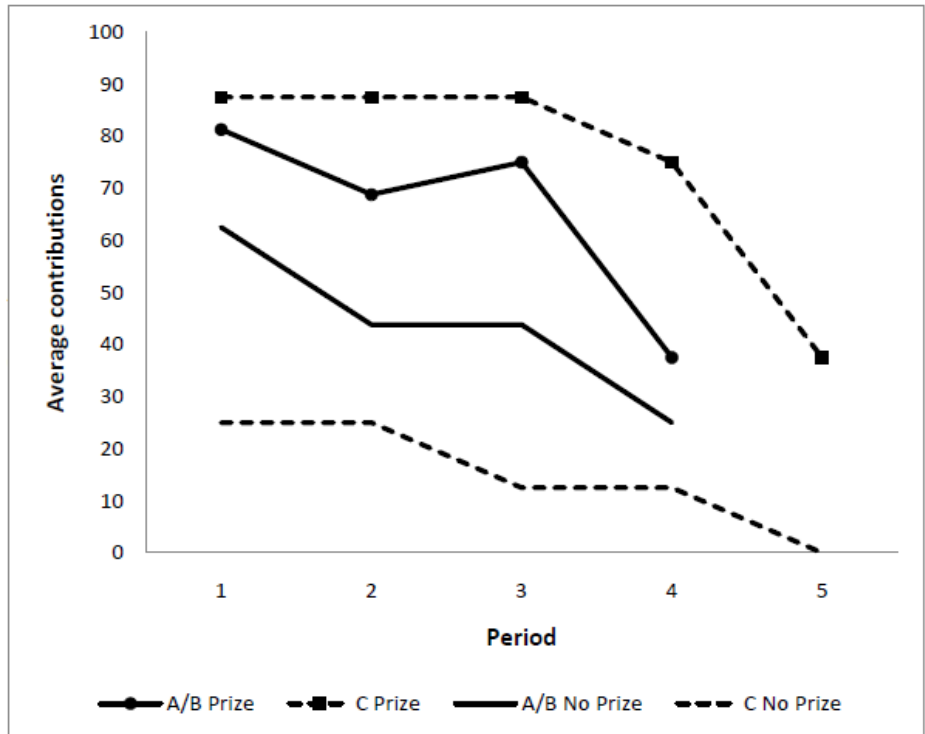
Figure 1: Average number of contributions, contingent on position, treatment and period. N=8 for each data point